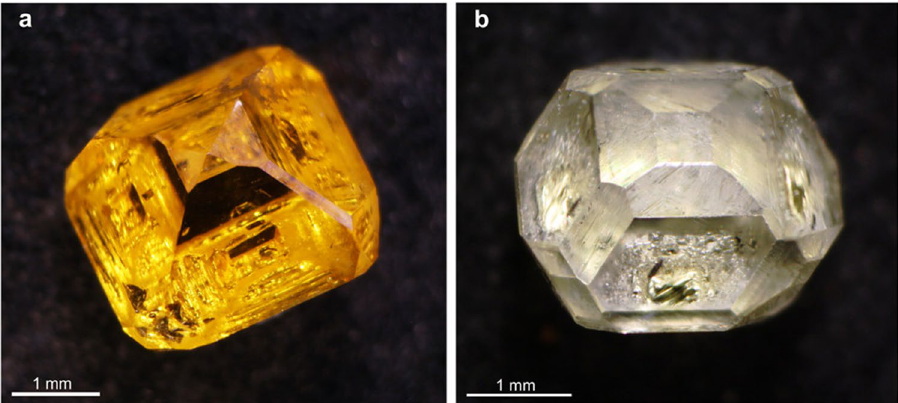
Figure 1. ( a ) Yellow synthetic diamond crystal grown in Fe–Ni–C system; ( b ) near-colorless synthetic diamond crystal grown in Fe–Ni–Ti–C